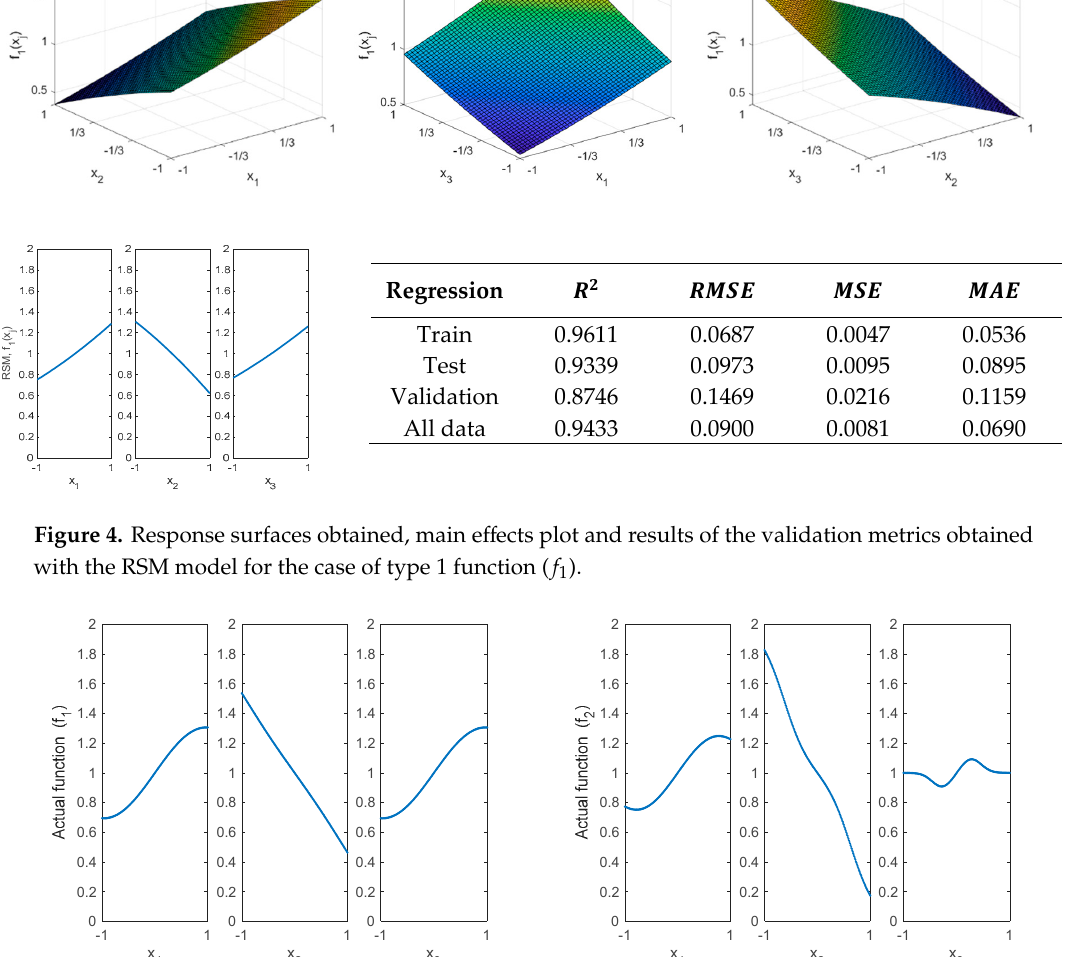
ff ects plot for f 1 and f 2